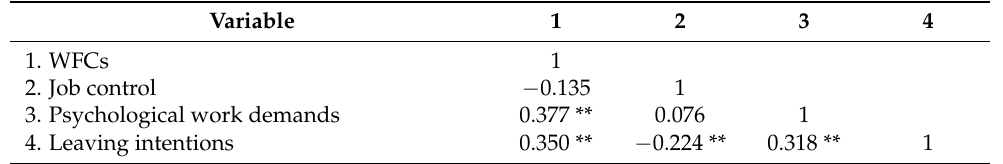
Table 2. Correlation of work–family conflicts (WFCs) with job control, psychological work demands, and leaving intentions ( N = 200).